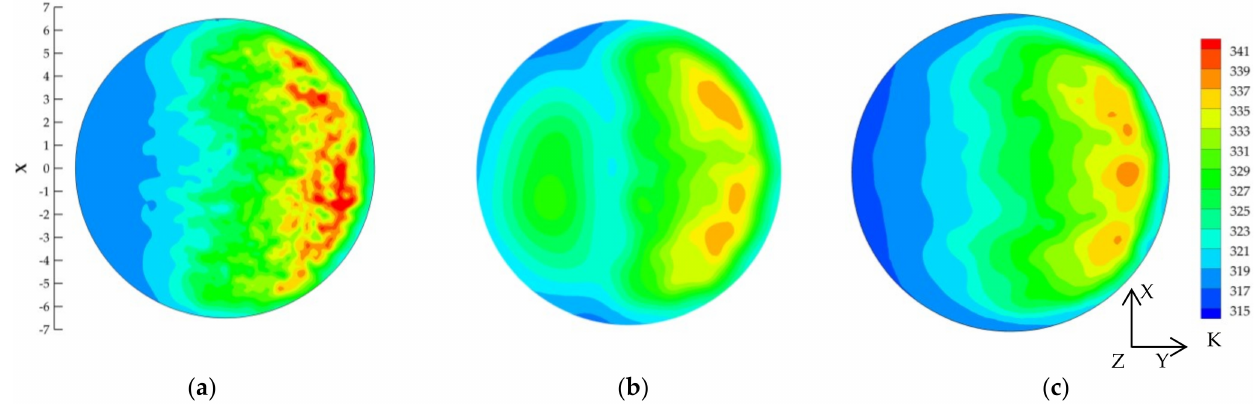
Figure 11. Distribution of flue gas temperature at Z = 8 m plane: ( a ) OST; ( b ) DST; ( c )